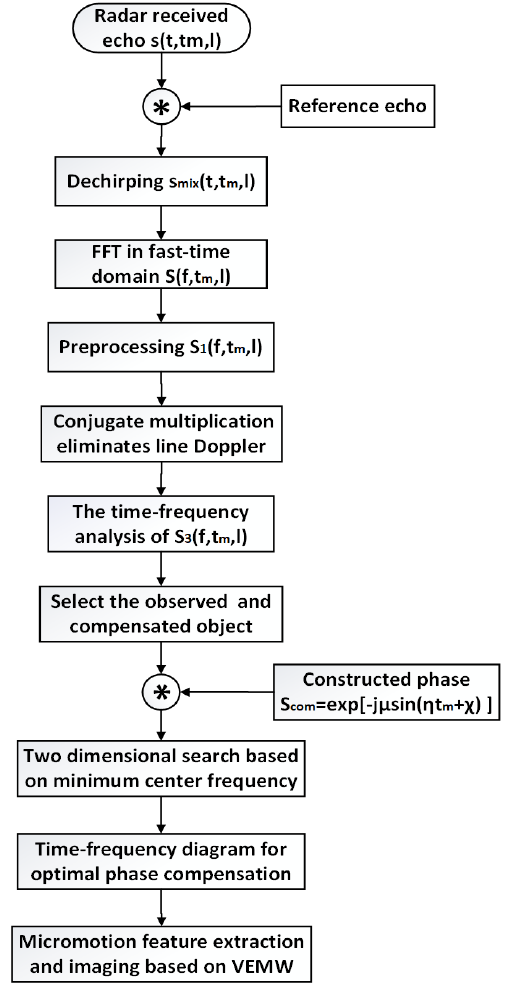
Figure 5. The flowchart of the proposed